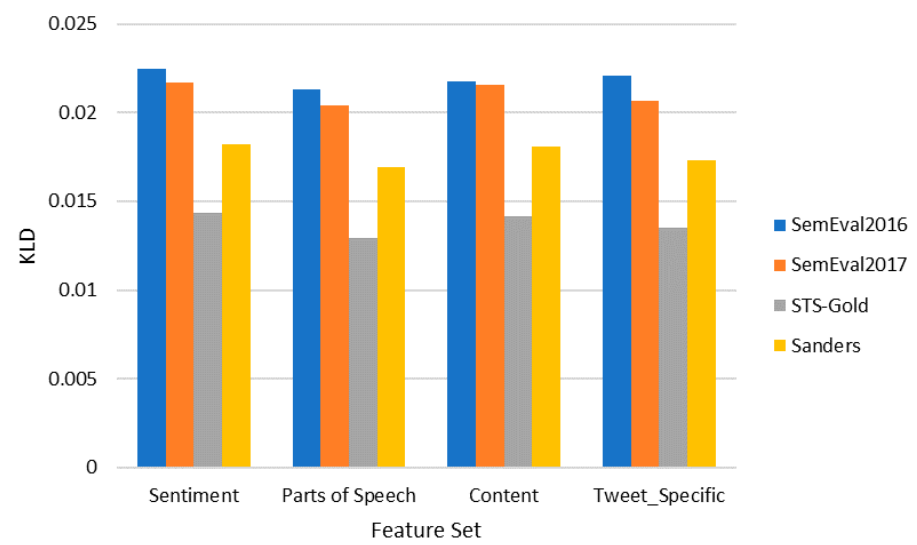
Figure 2. Comparison of single feature set performances.